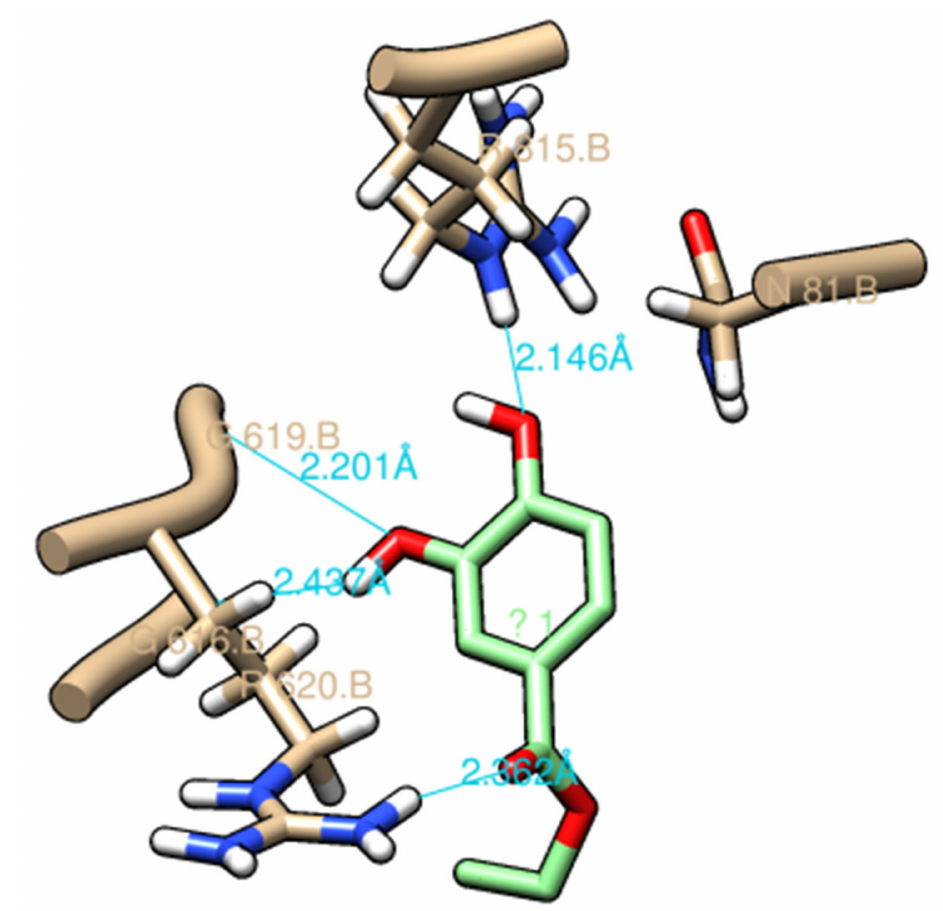
Figure 5. Closer view of molecular docking of EDHB to AcrB T-state monomer. Residues and hydrogen bonds (blue line) are shown within 3.5 Å from the